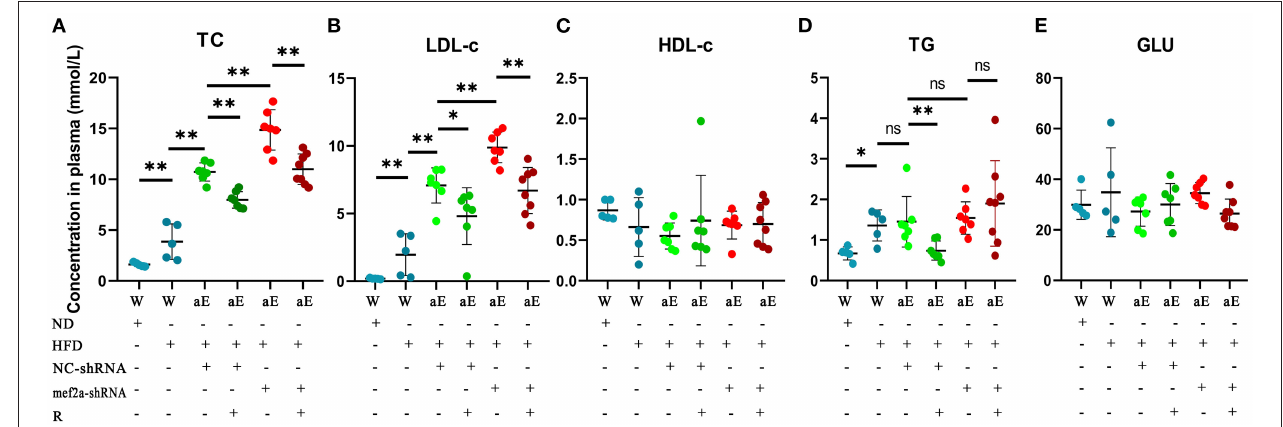
FIGURE 8 | The influence of gastric administration of resveratrol or silencing MEF2A in vascular endothelium of apoE − / − mice on plasma levels of cholesterol, lipid and glucose. (A) Total cholesterol (TC). (B) Low-density lipoprotein cholesterol (LDL-c). (C) High-density lipoprotein cholesterol (HDL-c). (D) Triglyceride (TG). (E) Glucose (GLU). W: wild type mice; aE: apoE − / − mice; ND, normal diet; HFD, high-fat diet; NC-shRNA, negative control (infection with NC-shRNA-AAV1); mef2a-shRNA, infection with mef2a-shRNA-AAV1; R, resveratrol; “-” indicates no treatment performed with the factor at the line; “ + ” indicates treatment performed with the factor at the line. The individual values are presented in dot plots and the values distribution is represented as mean ± standard deviation (SD). The statistical significance is analyzed by the Mann-Whitney U test. ns, no significance; * P < 0.05; ** P < 0.01 between groups